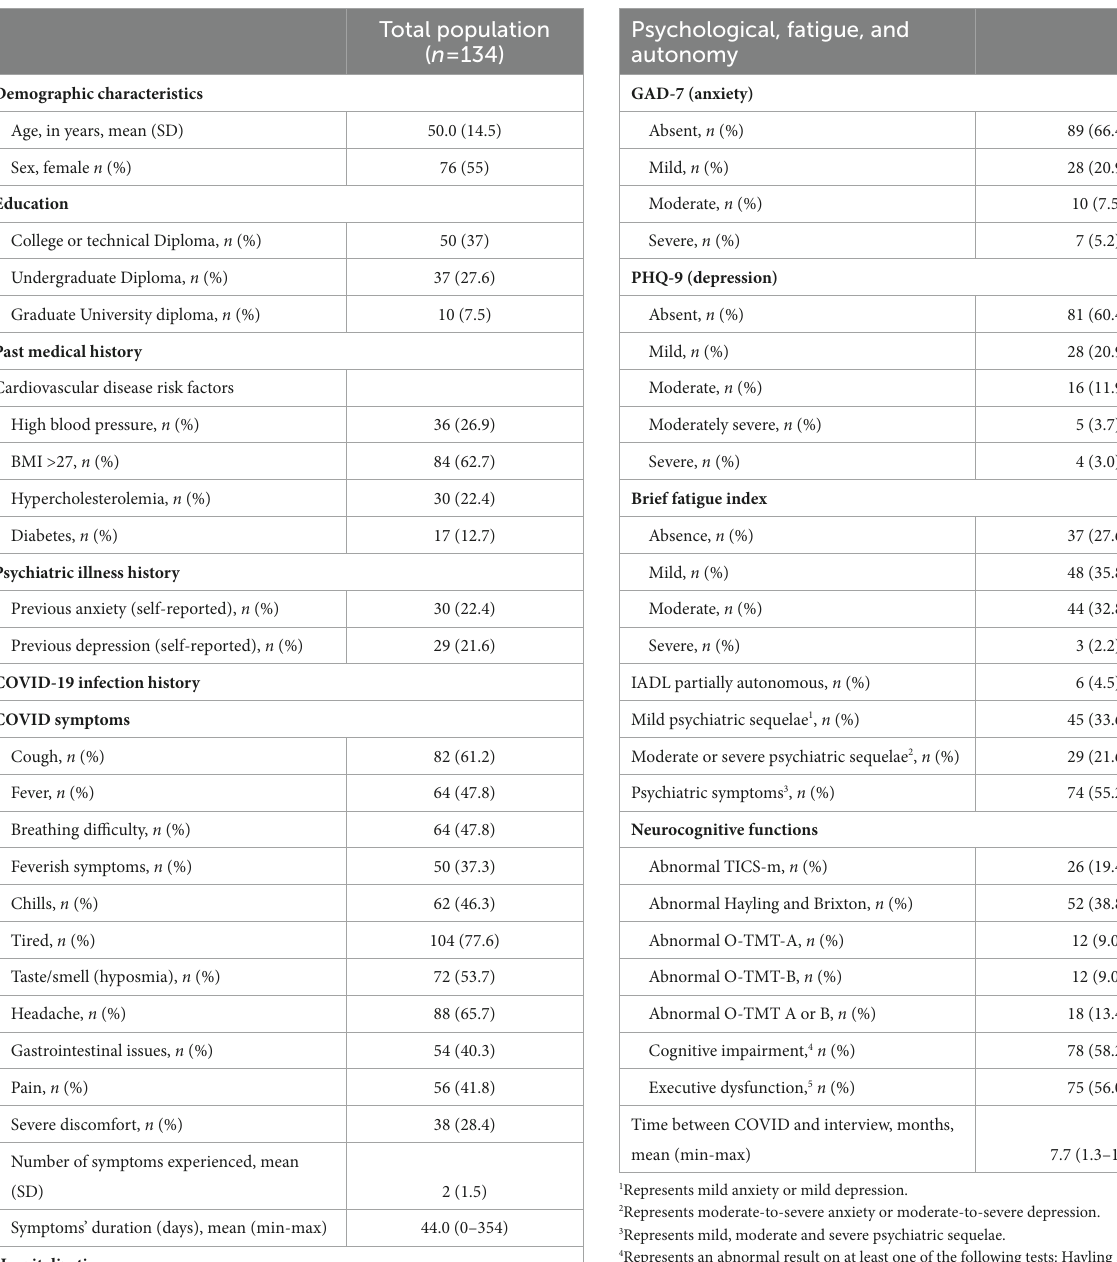
TABLE 1 Characteristics of the study sample. TABLE 2 Post-COVID-19 neuropsychological assessment.